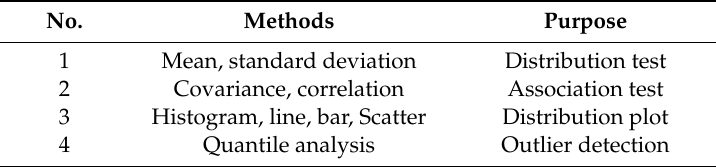
Table 7. Statistical analysis methods on the selected